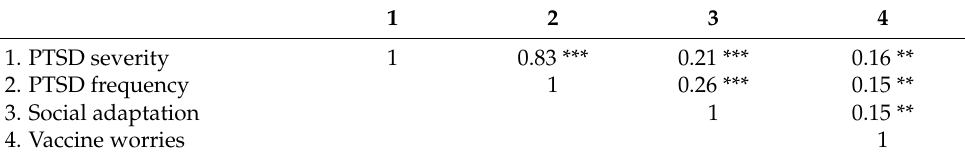
Table 2. The correlation matrix of measured variables.